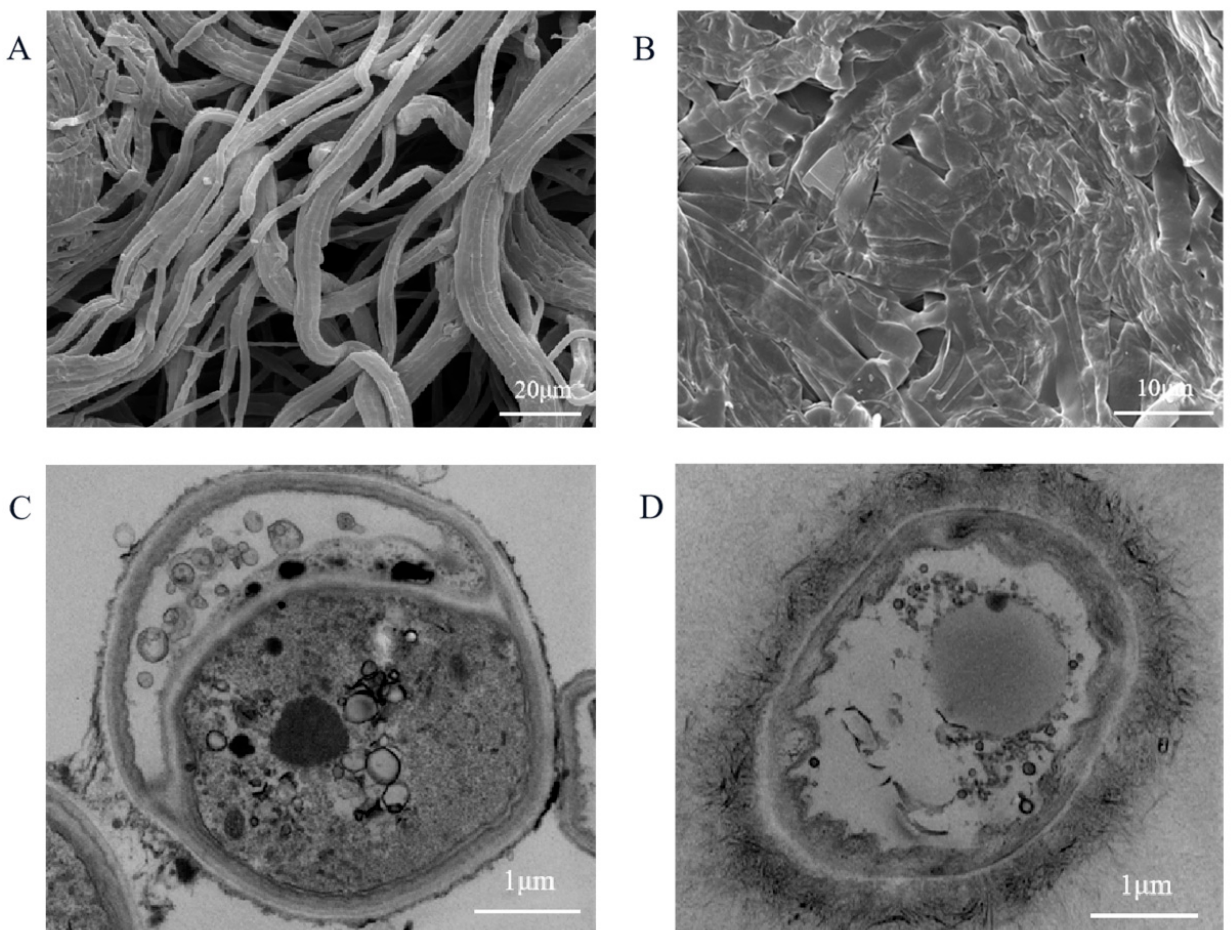
Figure 4. The effect of geraniol on C. camelliae mycelia and internal structure; ( A ) the SEM of C. camelliae ; ( B ) the SEM of C. camelliae were treated with geraniol; ( C ) the SEM of C. camelliae ; ( D ) the TEM of C. camelliae was treated with geraniol. Scale bar ( A ) = 20 µ m, ( B ) = 10 µ m, ( C , D ) = 1 µ m. Under the observation of SEM and TEM, the cell wall and membrane were obviously destroyed. As expected, geraniol could significantly increase the enzyme activity of CE and damage the integrity of the cell wall structures. MDA is an important indicator of membrane lipid peroxidation, and elevated levels of MDA could directly lead to cell damage [29]. Soluble protein is one of the components of the cell membrane, which reflects the integrity of the cell membrane [30]. The increase of MDA content and the decrease of soluble protein content showed that geraniol damaged the cell membrane to a considerable extent. The reduction in POD and SOD activities indicated that geraniol treatment of C. camelliae inhibited the activities of defense enzymes, resulting in excessive accumulation of intracellular H 2 O 2 and interfering cellular metabolism. SDH is a mitochondrial marker enzyme and one of the critical links between respiratory electron transport and oxidative phosphorylation [31]. MDH is an essential enzyme in the TCA cycle and a key enzyme in the process of glucose metabolism, which exists in the cytoplasm and mitochondria of fungal cells [32]. When the activities of SDH and NAD-MDH were decreased overall, the mitochondrial membrane and plasma membrane of C. camelliae were damaged, which may affect the level of respiratory metabolism and interfere with the TCA cycle pathway. In addition, consistent studies have shown that Curcuma longa could decrease the activity of SDH, thus inhibiting the TCA cycle in mitochondria, interfering with ATP synthesis, and inhibiting the respiratory chain of Fusarium graminearum